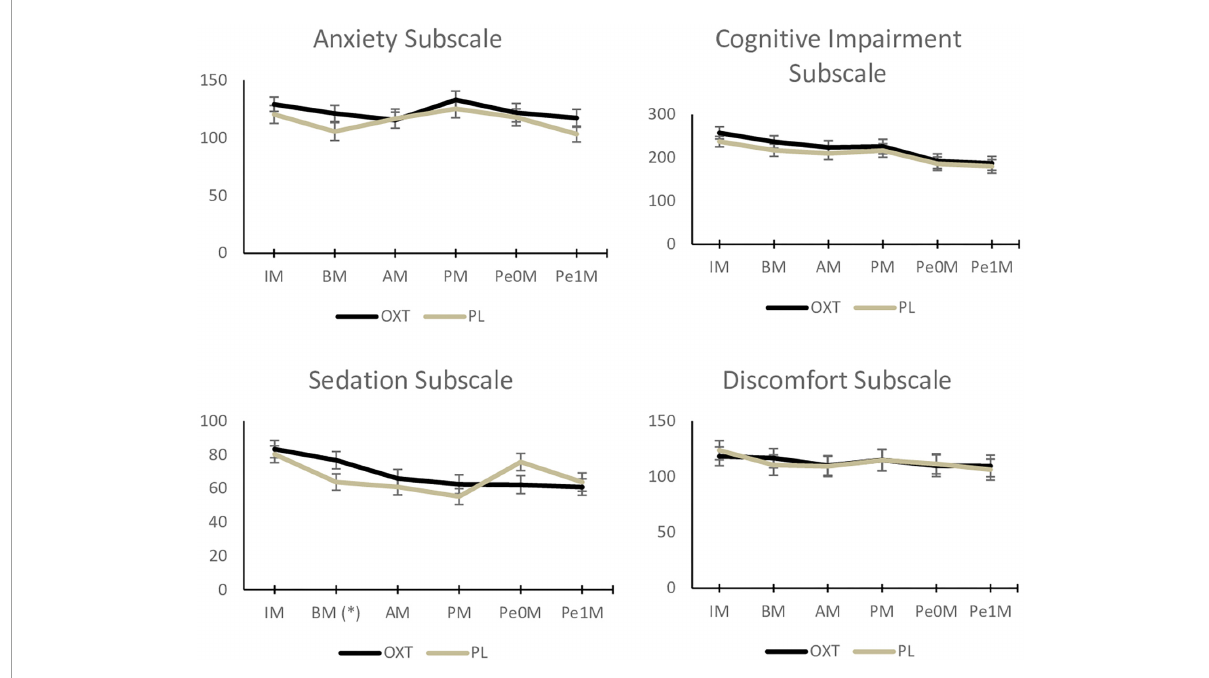
FIGURE3 Effects of oxytocin and placebo on self-perception of performance (Visual Analogue Mood Scale) (OXT, oxytocin; PLA, placebo; IM, Initial Measure; BM, Baseline Measure; AM, Pre-stress/Anticipation Measure; PM, Execution/Performance Measure; PeOM, Immediate Post-stress/Recovery Measure; Pe1M, Late Post-stress/Recovery Measure; ∗ difference with statistical significance = p < 0.05; error bar = standard